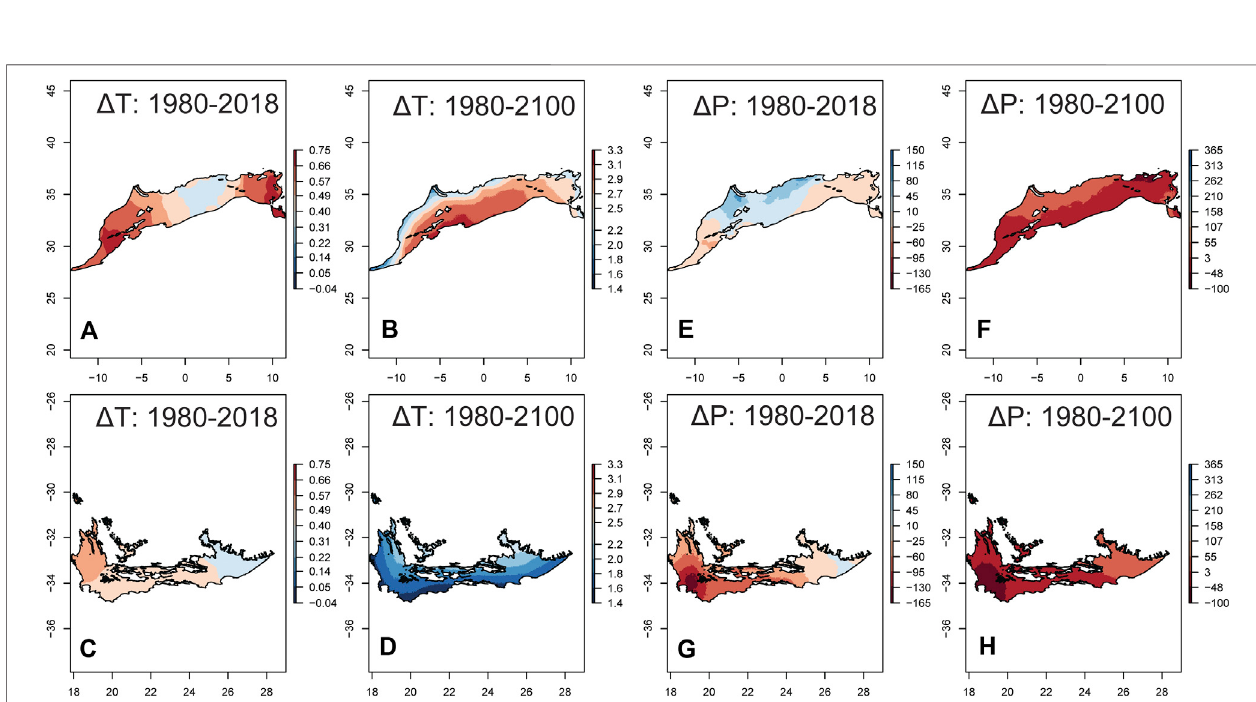
FIGURE 4 | Temporal change in the average annual temperature ( Δ T) and annual precipitation ( Δ P) in the Mediterranean climate of North African (NAR) and South African regions (SAR). We used 1980 – 1999 as a reference period to calculate Δ T and Δ P. Temporal changes for 1980 – 2018 was calculated by subtracting the